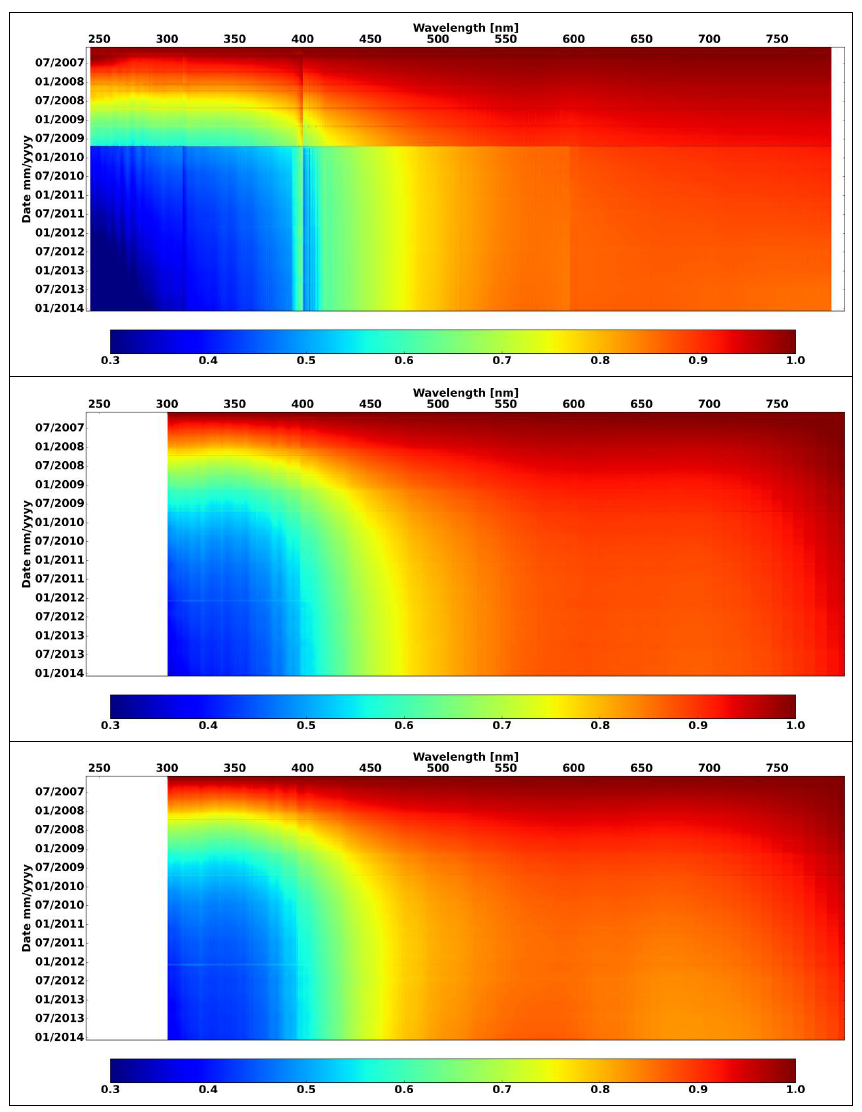
Figure 15. SMR spectra for all four main channels (upper panel), PMD-S (middle panel), and PMD-P (lower panel) normalized to Jan- uary 2007. The discontinuity in the main channels in September 2009 is the second throughput test (EUMETSAT, 2011). The discontinuities in spectral space for the main channels are the channel overlap